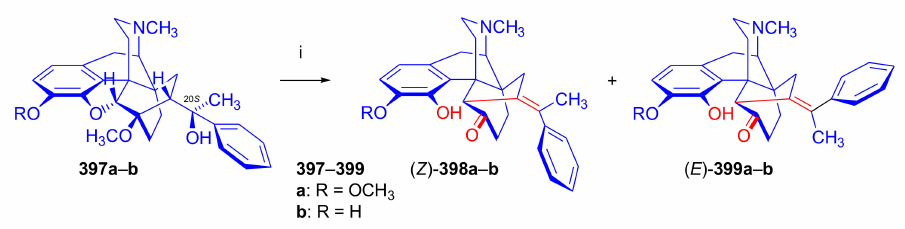
Figure 101. Synthesis of flavonepenthone analogues. Reagents and conditions : (i): 12M hydrochloric acid, 100 ◦ C, 2